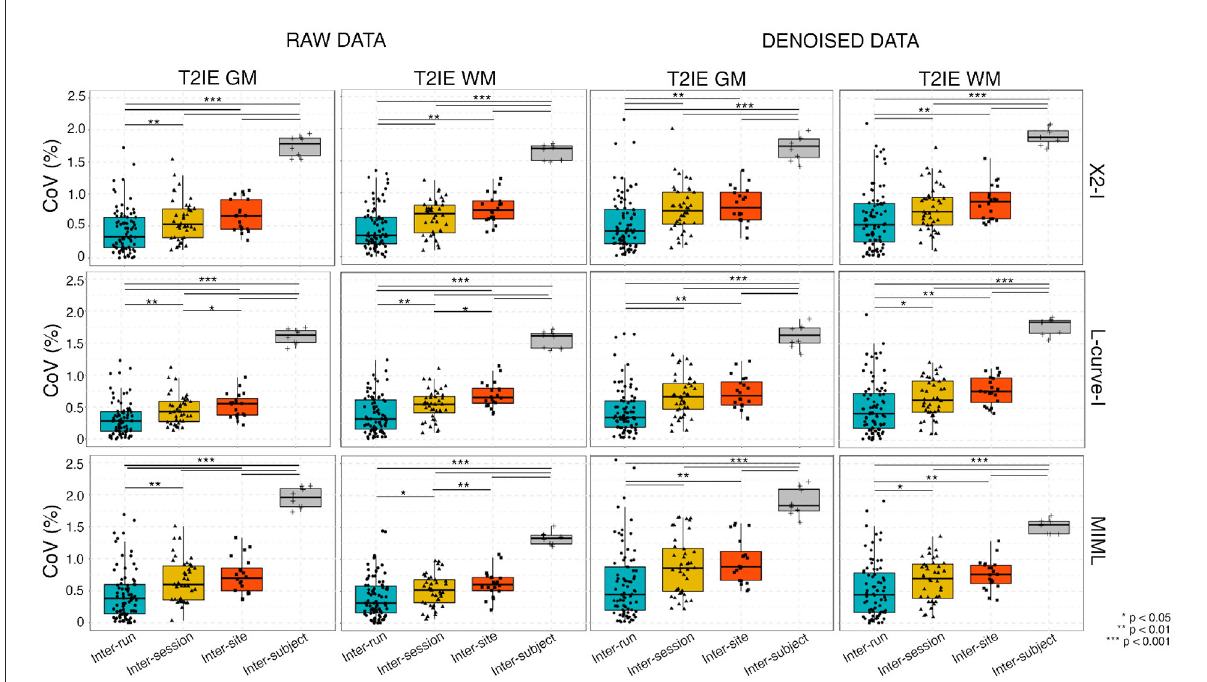
FIGURE2 Variability of T IE 2 for all reconstructions for both GM and WM for the raw data (without denoising, columns 1 and 2) and denoised data (columns 3 and 4): Coefficient of variation (CoV) across inter-run (scans acquired within the same session of the same subject on the same scanner), inter-session (scans acquired between different sessions of the same subject on the same scanner), inter-site (scans acquired between different sessions of the same subject on different sites) and inter-subject (average of the scans of different subjects in different sessions on the same scanner) groups. Increased variability is seen with session, scanner and subject effects, for both the raw data and the denoised data. Statistical differences between effects were assessed using a Wilcoxon rank-sum test with Bonferroni